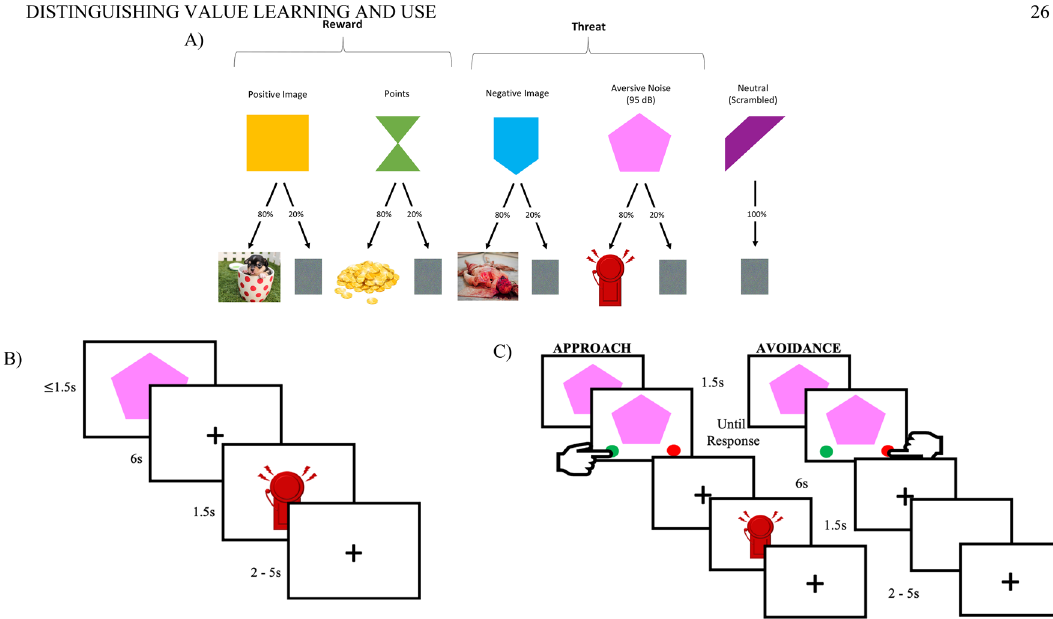
Figure 1. Task schematics. ( A ) Example of neutral shape—reinforcer pairings and probability ratios. Neutral shapes were paired with either a positive image, points reward, negative image, or aversive noise 80% of the time and neutral scrambled image 20% of the time. One shape was always paired with the neutral scrambled image. Images were taken from the Open Affective Standardized Image Set (OASIS; Positive Image: I256; Negative Image: I287), an open access set of images with standardized ratings of valence and arousal 50 . ( B ) Example of a trial in the conditioning task. ( C ) Example of a trial in the behavioral choice task. Pressing the green button resulted presentation of the reinforcer; pressing the red button resulted in presentation of a blank screen. Thus, pressing the green button represents an approach response and pressing the red represents an avoidance response. Figure adapted from Smith and Pollak 47